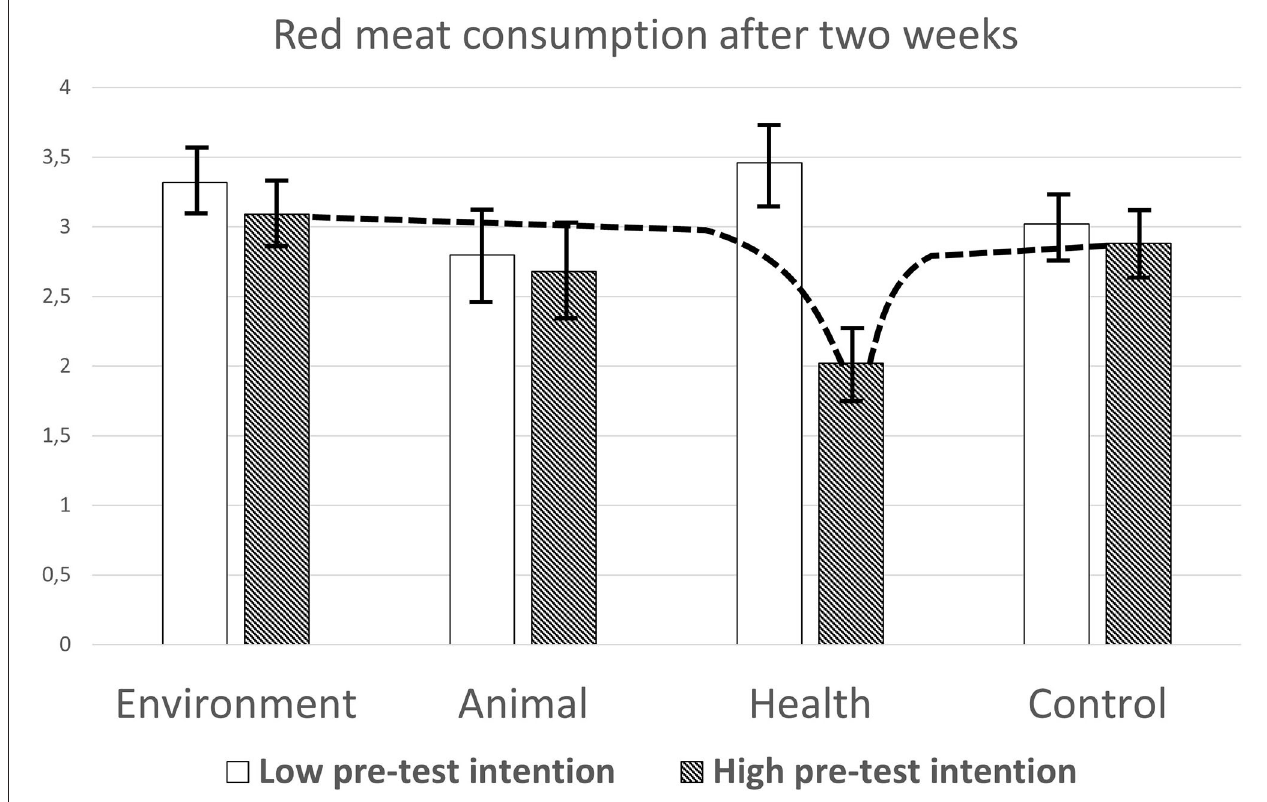
FIGURE 2 | Levels of self-reported red meat consumption after 2 weeks in the four conditions, according to the pre-test intention level. Dotted lines represent significant contrasts. Error bars refer to